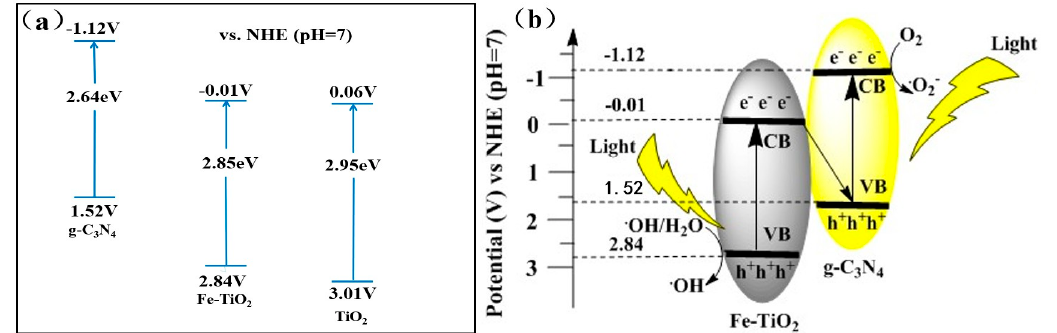
Figure 10. ( a ) Electronic band structure of the respective catalysts; ( b ) Z ‐ scheme photocatalytic mechanism for g ‐ C 3 N 4 /Fe ‐ TiO 2 composites.